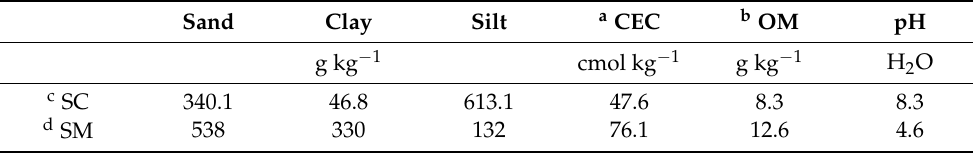
Table 2. Identification for treatments according to the mixture of contaminated mine soil (SC), forest soil (SM), biochar (BC) and biochar impregnated with Fe (BFe). Treatments Identification Control: contaminated soil (100%) TC-SC Control: forest soil (100%) TC-SM Contaminated soil (50%) + forest soil (50%) SC + SM Contaminated soil (50%) + forest soil (45%) + biochar